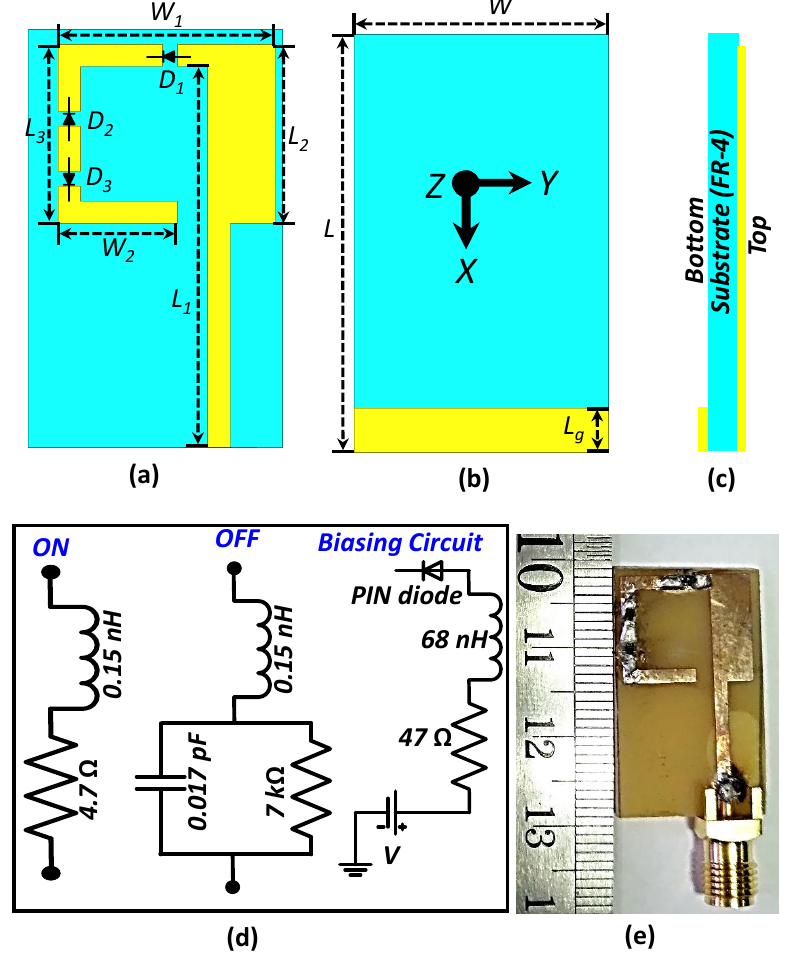
Figure 1. Geometry of the proposed antenna: ( a ) top view ( W 1 = 14.5 mm, L 2 = 12 mm, W 2 = 8 mm, L 3 = 12 mm, and L 1 = 25.5 mm); ( b ) bottom view ( W = 17 mm, L = 28 mm, and L g = 2 mm); ( c ) side view, ( d ) equivalent circuit model of the PIN diode in the ON, OFF state and the biasing circuit, and ( e ) fabricated prototype.